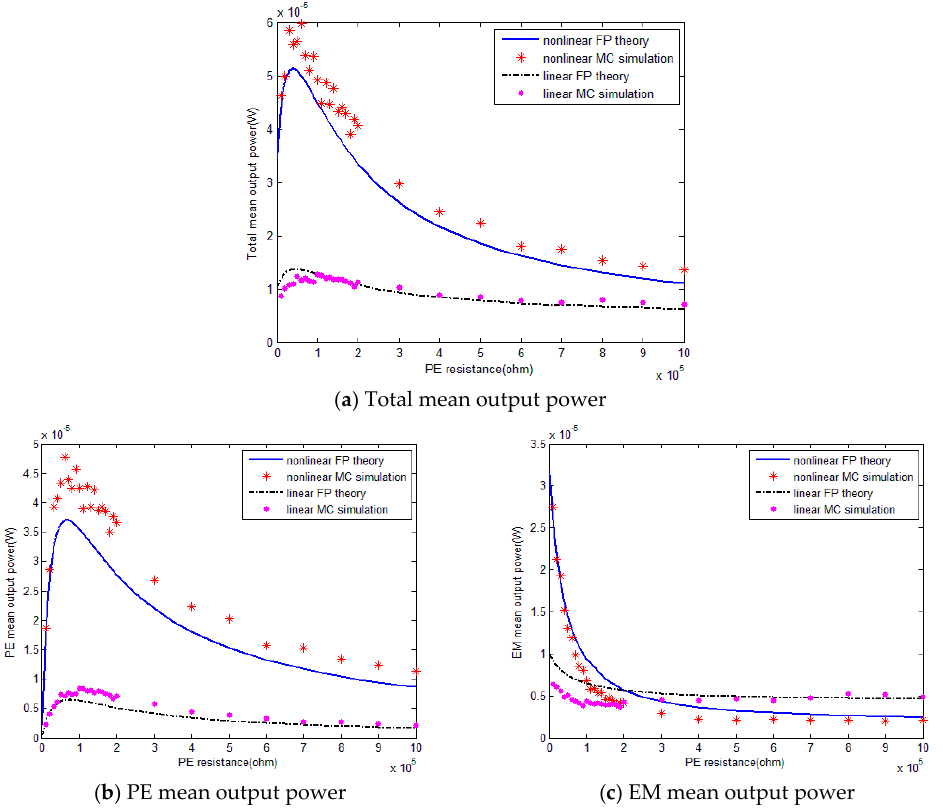
Figure 3. Theoretical and numerical mean output power of hybrid energy harvester with PE load resistances.